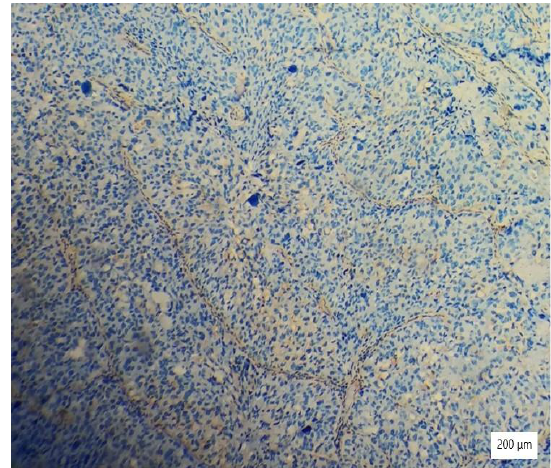
Figure 9. Variable, low expression pattern of P16 in tumor cells (×100).